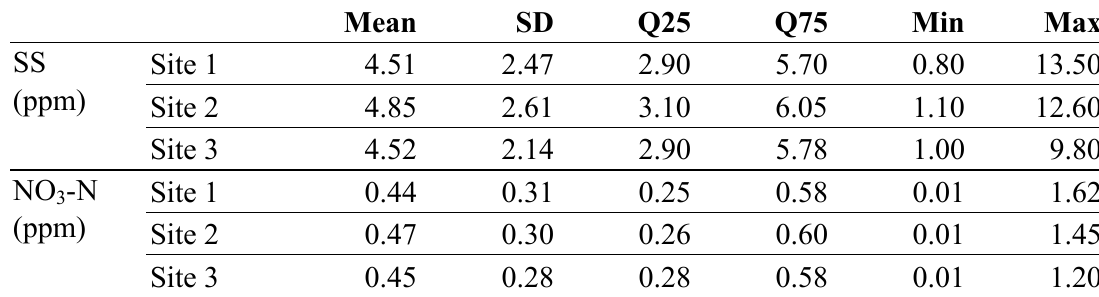
Table 3. Descriptive statistics of SS, and NO stations during 2001–2010.